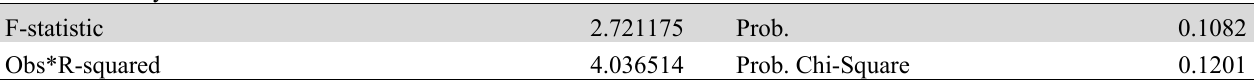
Breusch-Godfrey Serial Correlation LM Test